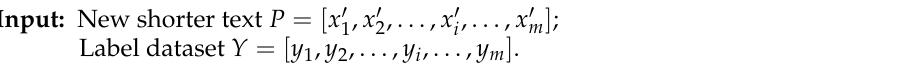
Algorithm 3 Model training